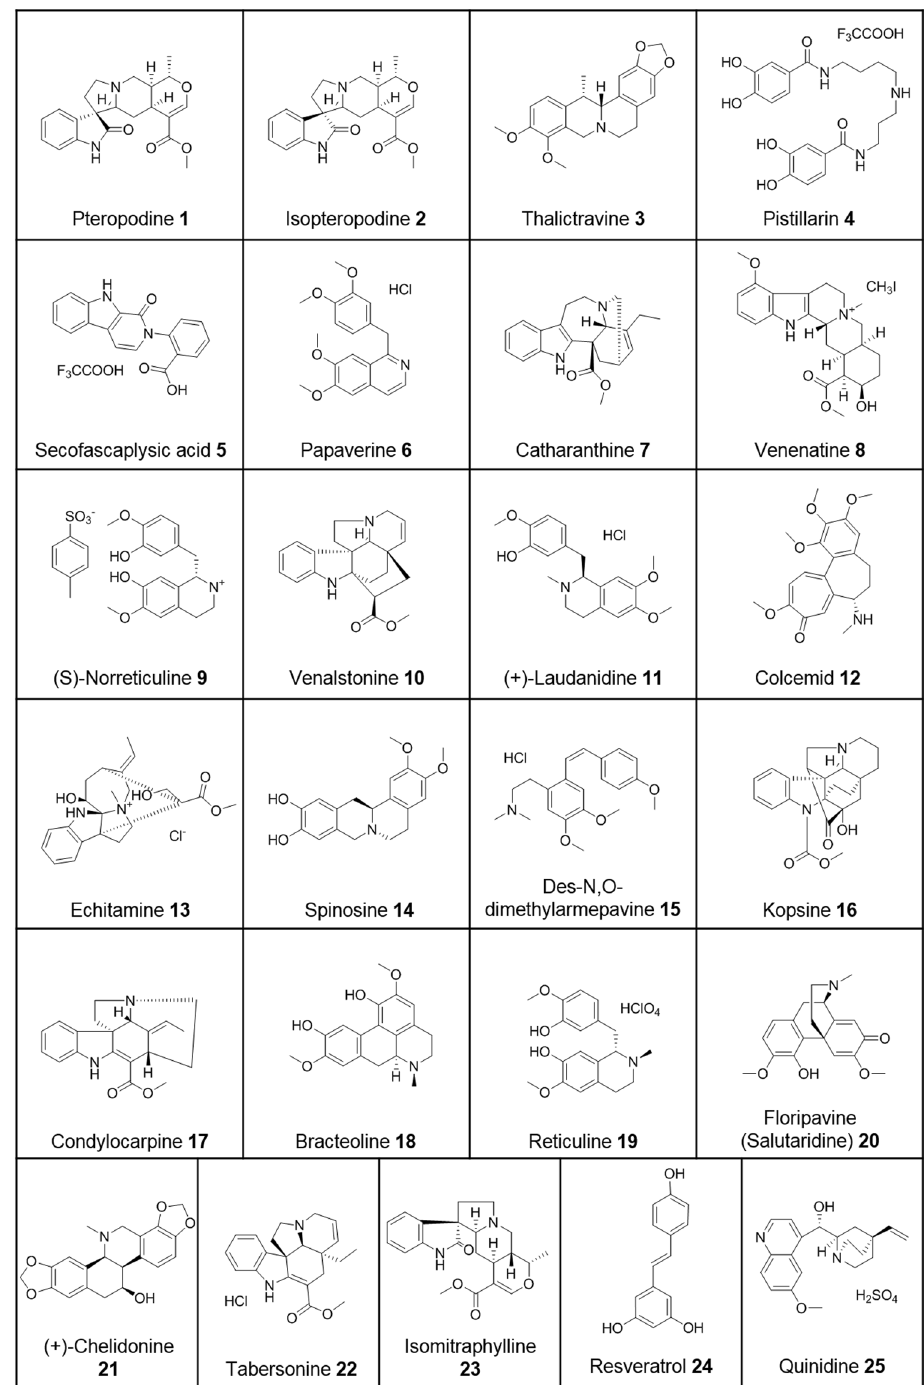
Figure 5. 2D-Structures of the compounds tested in vitro